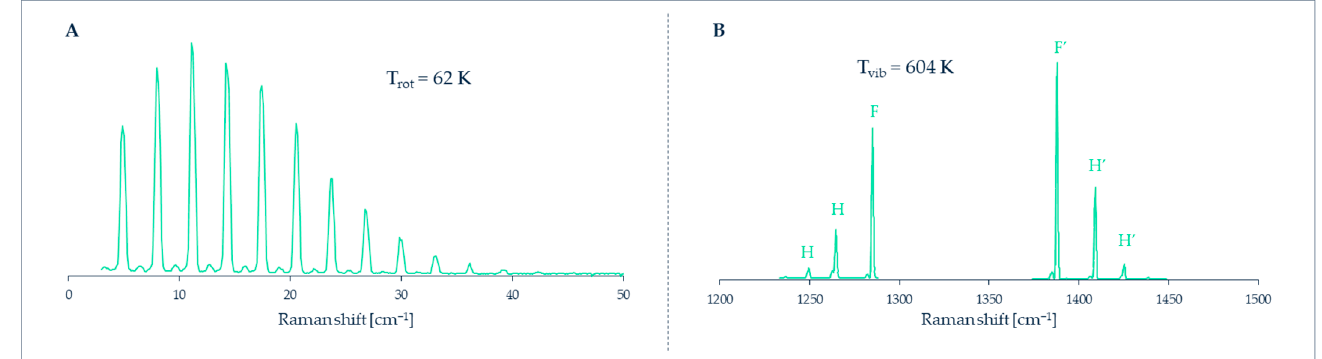
Figure 24. Raman spectra of supersonic jets of CO 2 from a 0.4 mm nozzle. ( A ) Rotational Raman spectrum; the resolved rotational lines correspond to different angular momentum J . ( B ) Vibrational Raman spectrum; peaks labeled H, H’ are hot bands (corresponding to transitions starting from excited vibrational levels) of the F, F’ fundamental bands.